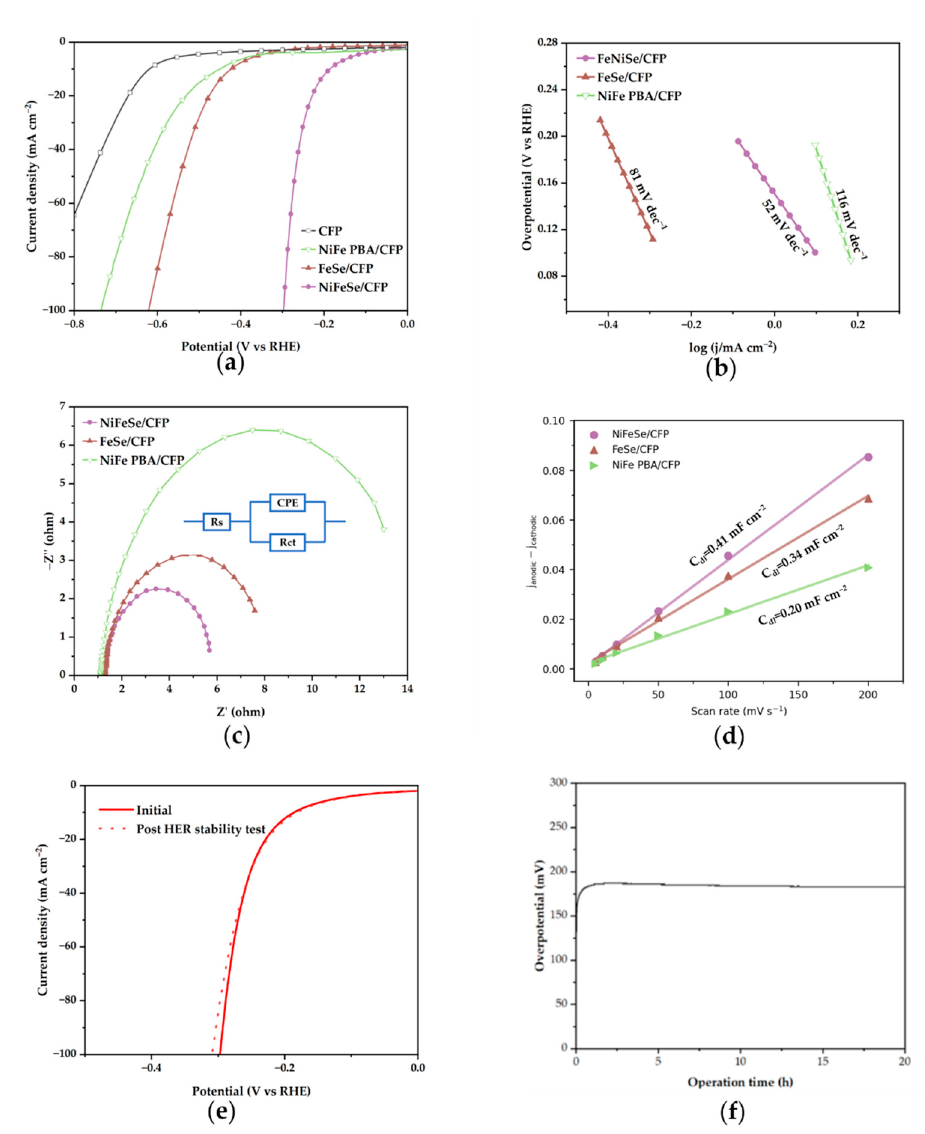
Figure 4. HER performance of the as-prepared catalysts in 1.0 M KOH at room temperature. ( a ) LSV polarization curves ( b ) Tafel plots, ( c ) EIS Nyquist plots and ( d ) C dl for the HER of NiFe PBA/CFP, FeSe/CFP and NiFeSe/CFP. ( e ) HER polarization curves of NiFeSe/CFP before and after 1000 CV tests. ( f ) The plot of the extracted corresponding overpotential at a current density of 10 mA cm − 2 .